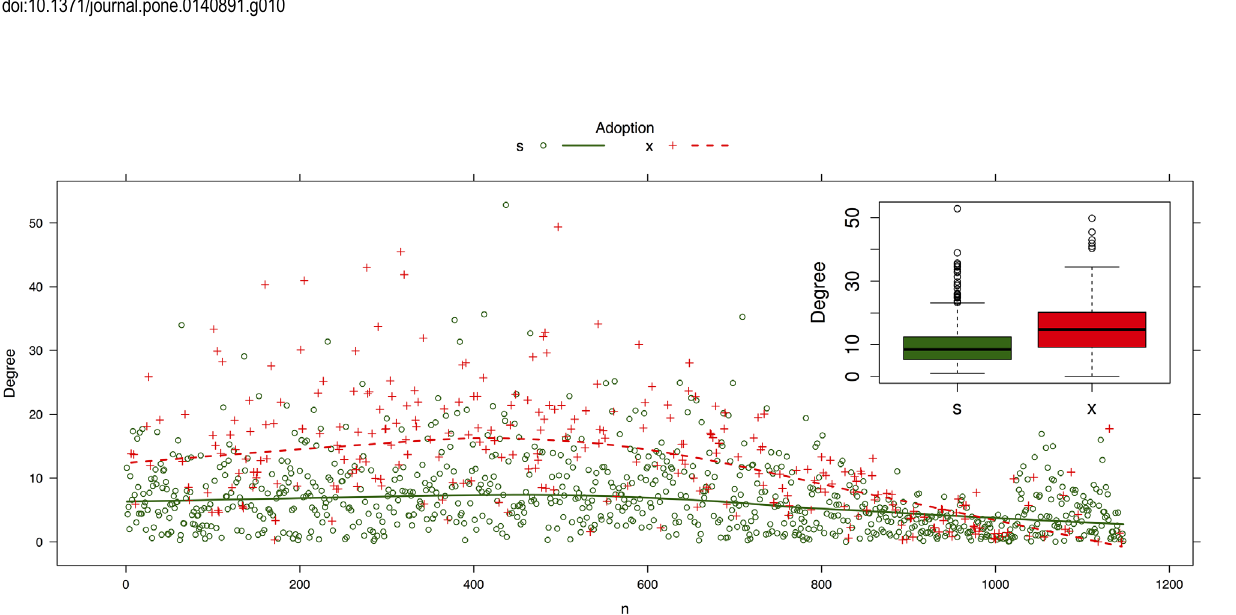
Fig 11. Mean degree of all network vertices sorted by adoption status. The red dots show infected vertices and the green dots represent susceptible vertices. The inset box chart clearly shows that the infected vertices have a higher degree.